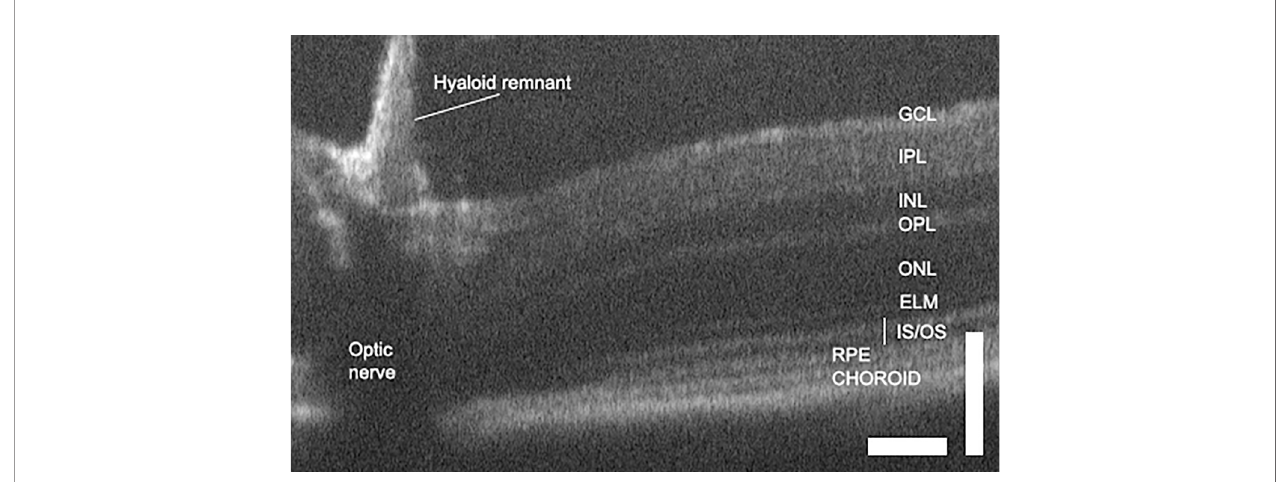
FIGURE 3 | OCT of the normal mouse retina delineates layers and allows retinal dimensions to be quanti fi ed. Scale bars are 100 microns and illustrate differences in axial and lateral resolution. GCL, ganglion cell layer; IPL, inner plexiform layer; INL, inner nuclear layer; OPL, outer plexiform layer; ONL, outer nuclear layer; ELM, external limiting membrane; IS/OS, inner and outer segments; RPE, retinal pigment epithelium